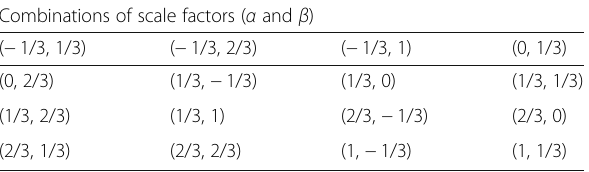
Table 5 Combination of scale factors ( α and β ) to produce the ensemble members Combinations of scale factors ( α and β